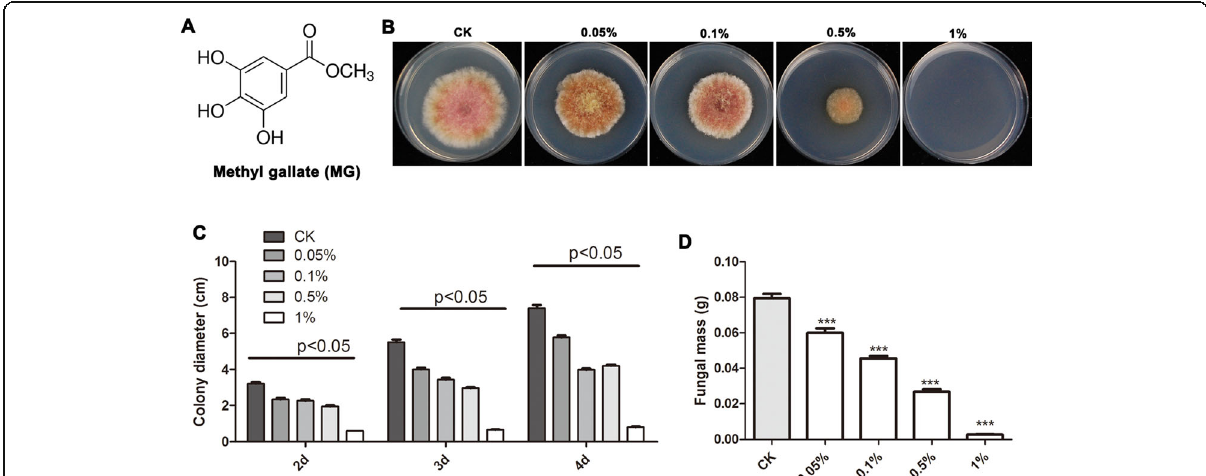
Fig. 1 MG inhibits the mycelial growth of F. graminearum . A Chemical structure of methyl gallate. B Colony morphology of F. graminearum strain PH-1 grown on PDA plates amended with different concentrations (w/v) of MG indicated in the figure and cultured at 25 °C, and colony diameters were measured at 2 d, 3 d, and 4 d after inoculation C . D Five mycelial plugs were inoculated into 100 mL PDB amended with different concentrations (w/v) of MG indicated in the figure and cultured in a shaker at 180 rpm, 25 °C for 3 days, fungal biomass was compared. Each treatment has three replicates, ***, p < 0.001